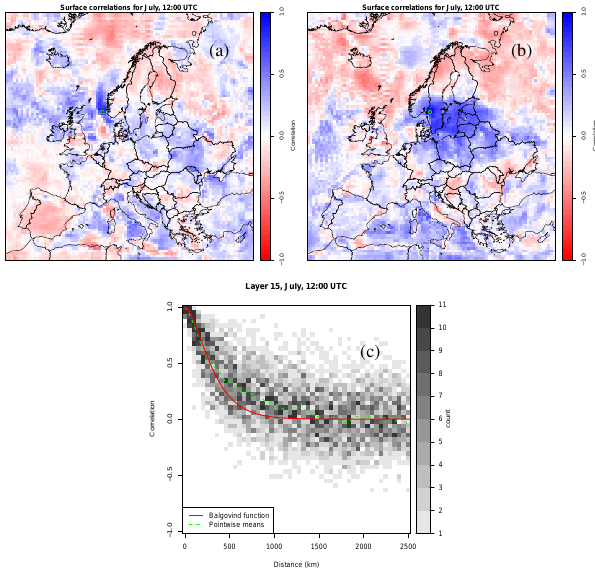
Fig. 3. Top row: sample correlations between a selected point (highlighted with a green circle) and all other grid-points, shown for the surface layer. Bottom panel: An example of background error correlations as a function of horizontal separation between pairs of grid points on the same vertical layer. The fitted Balgovind correlation function (Eq. 6) is shown, as well as the moving average value (av- eraged over 50km windows). The colour scale shows the number of points inside each of the 27